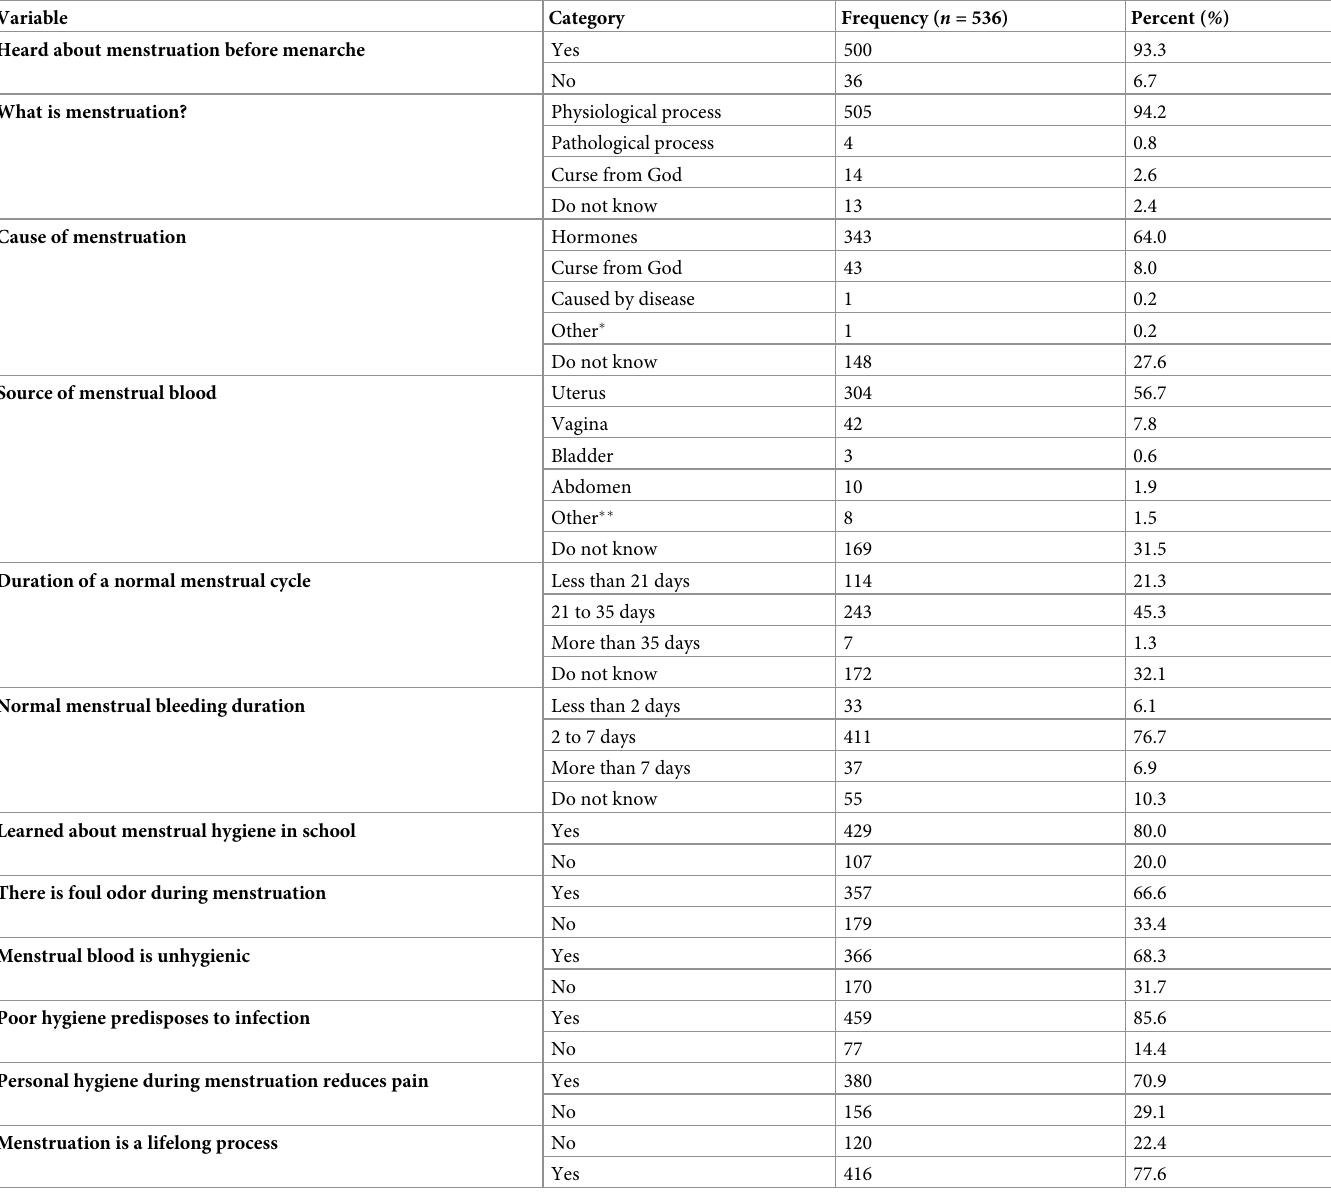
Table 3. Knowledge about menstruation among high school girls of Dessie City, Amhara Region, northeastern Ethiopia, 27 January to 6 March 2020.